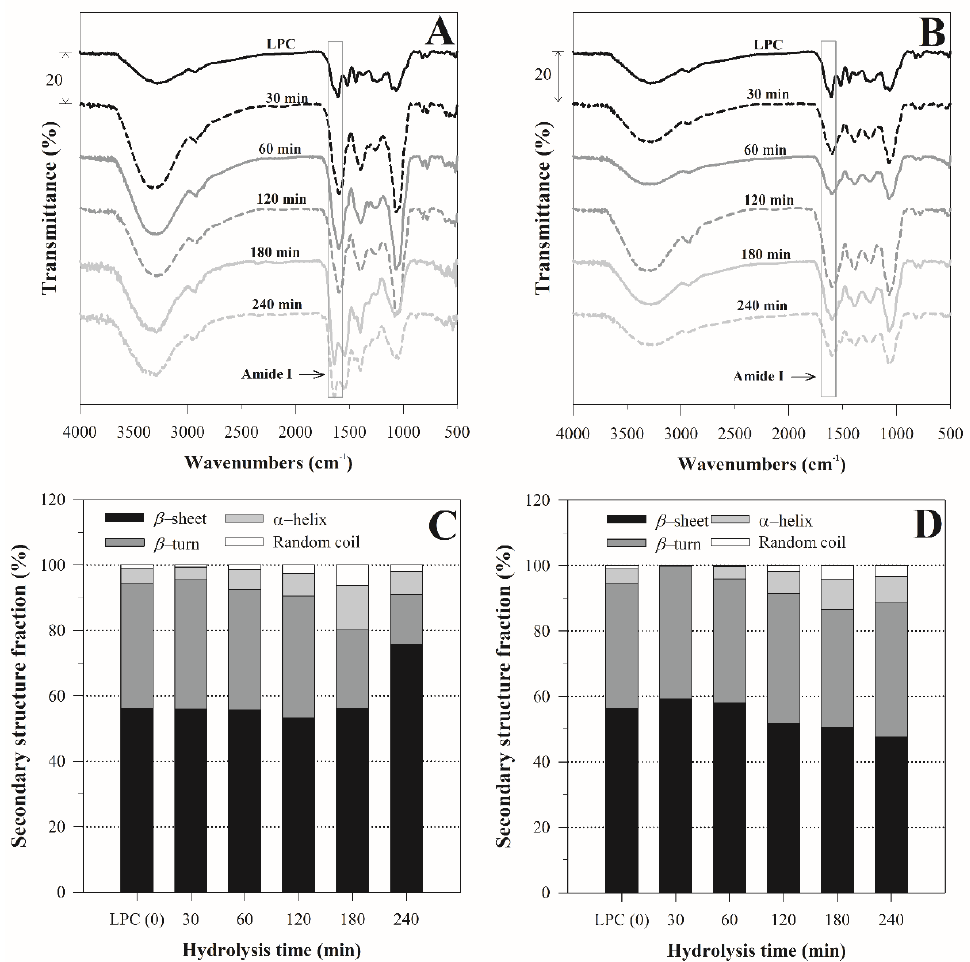
Figure 1. FTIR spectra ( A , B ) and secondary structure fractions ( C , D ) of leaf protein concentrate (LPC) and protein hydrolysates obtained with pepsin ( A , C ) and pancreatin ( B , D ) at different hydrolysis times. Table 2. FTIR analysis of LPC and its hydrolysates.